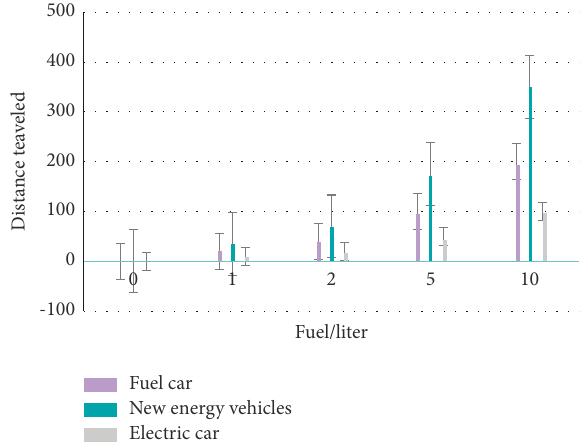
Figure 4: Analyze the distance traveled by three kinds of cars using the same quality of energy.